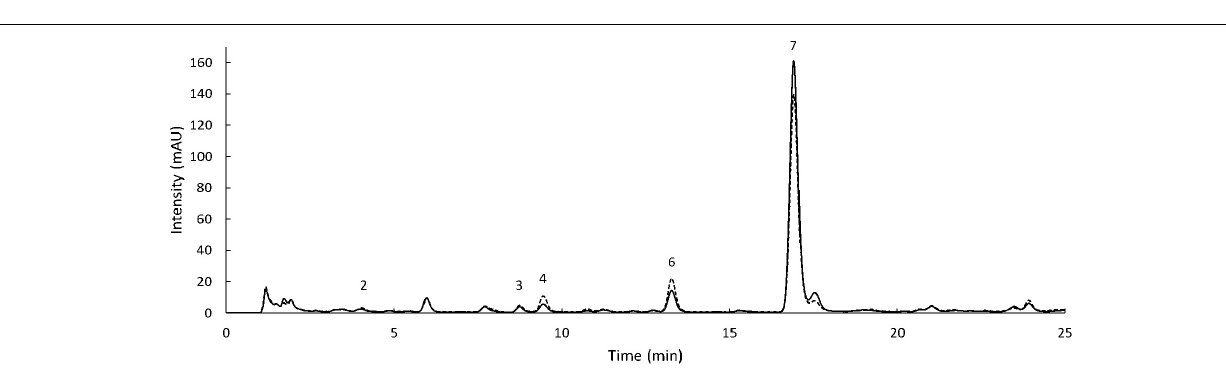
(Kambal and Bate-Smith, 1976). The flavone apigenin and the flavanone naringenin were also detected in all sorghum varieties, but at lower concentrations, between 1.14 and 11.02 µ